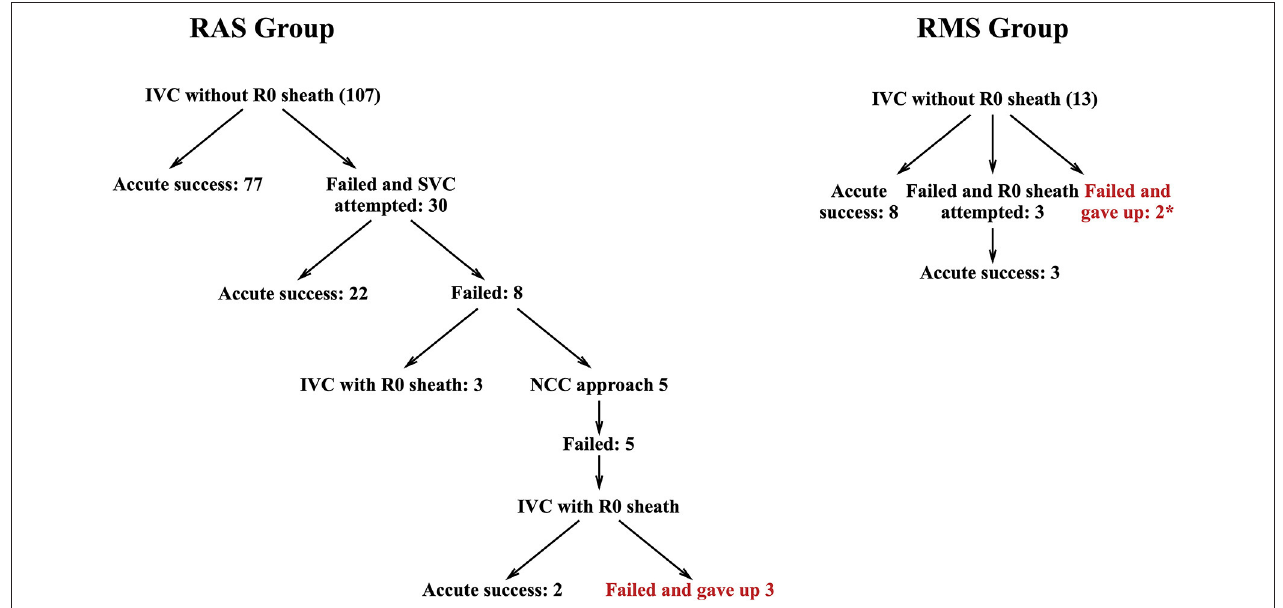
FIGURE 3 | Flowchart of ablation protocol in RAS and RMS group.* 1 patient gave up directly because of mechanical trauma-induced AV block and another one had AV block during ablation. RAS, right anteroseptal; RMS, right